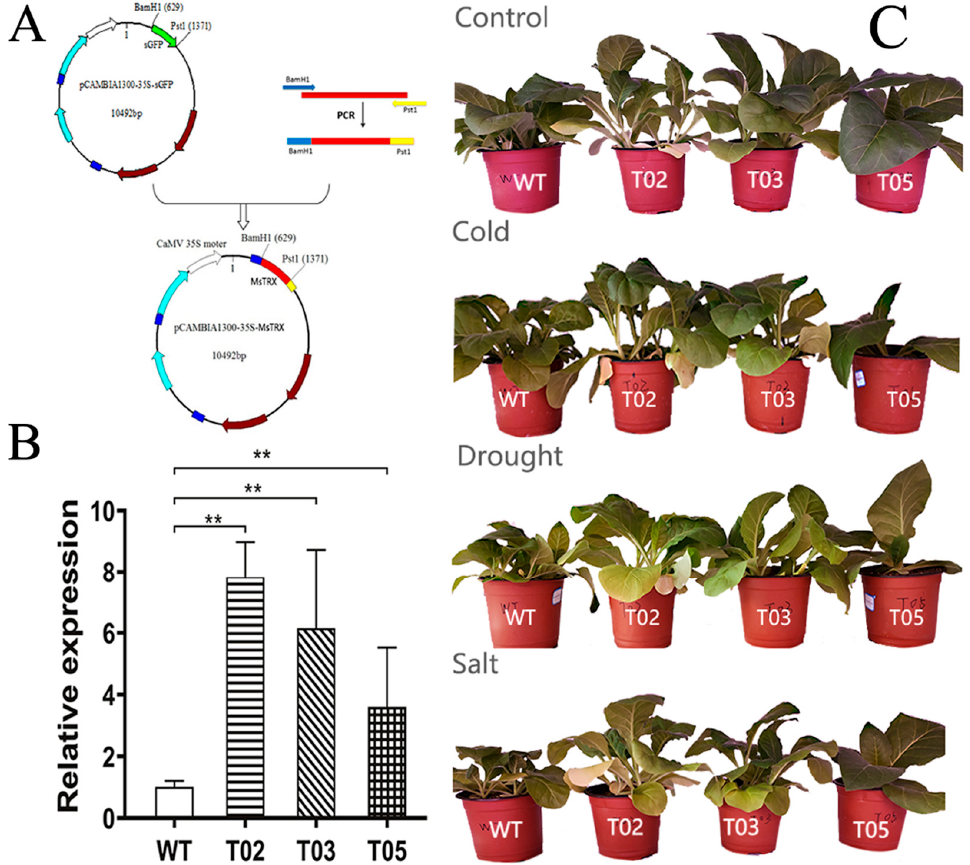
Figure 2. Stress tolerance tests of transgenic tobacco overexpressing MsTRX. ( A ) The illustration of pCAMBIA1300-35S:: MsTRX recombinant vector. ( B ) Expression of MsTRX in the T2 generation of transgenic tobacco and WT plants. ( C ) The phenotypes of overexpressed MsTRX tobacco and WT plants under control and cold, drought, and salt treatments. The transgenic tobacco and WT plants at 4 weeks old were treated with 4 °C, 20% PEG-6000, and 150 mM NaCl, individually. WT: wild type. T02: line 2. T03: line 3. T05: line 5. **, p < 0.01.